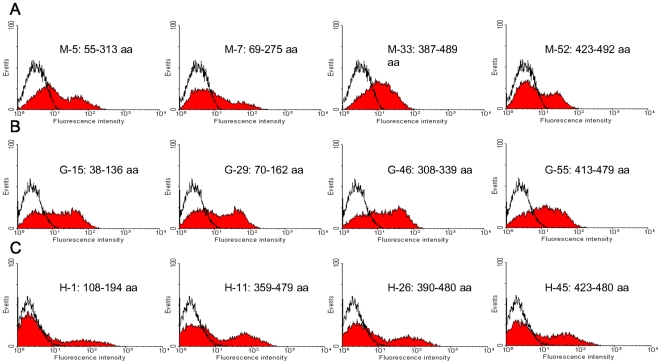
FCM histograms of representative yeast clones.The FCM signal for cells displaying antigenic peptides (the area filled by red color) overlaid with the FCM signal of non-expressing cells containing pCTCON-2 (the black curve) is shown. The designation of the clones follows the same order indicated in Fig. 2. The corresponding HA residues for each clone are illustrated. (A) FCM signals for clones M-5, M-7, M-33, and M-52 from screening against mouse antisera. (B) FCM signals for clones G-15, G-29, G-46 and G-55 from screening against goat antisera. (C) FCM signals for clones H-1, H-11, H-26 and H-45 from screening against human plasma.